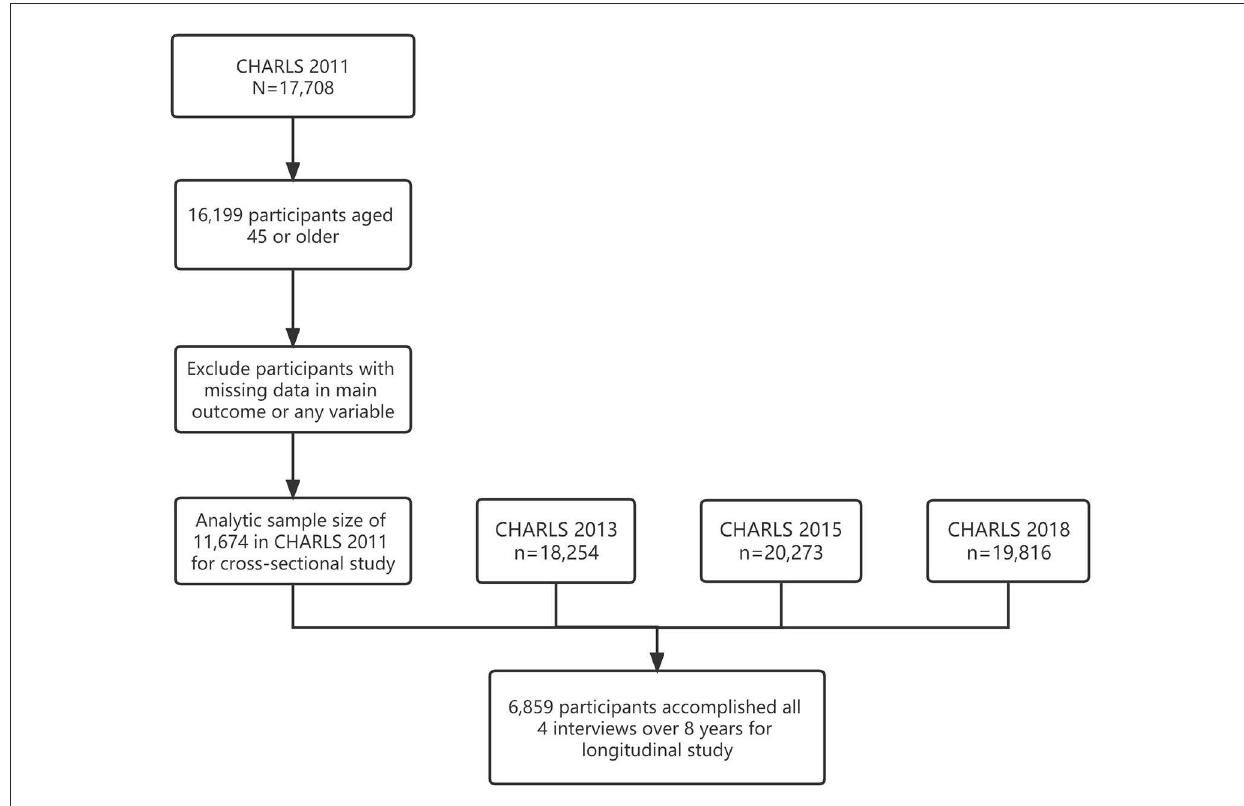
FIGURE1 Graphic abstract of sample screening of the present